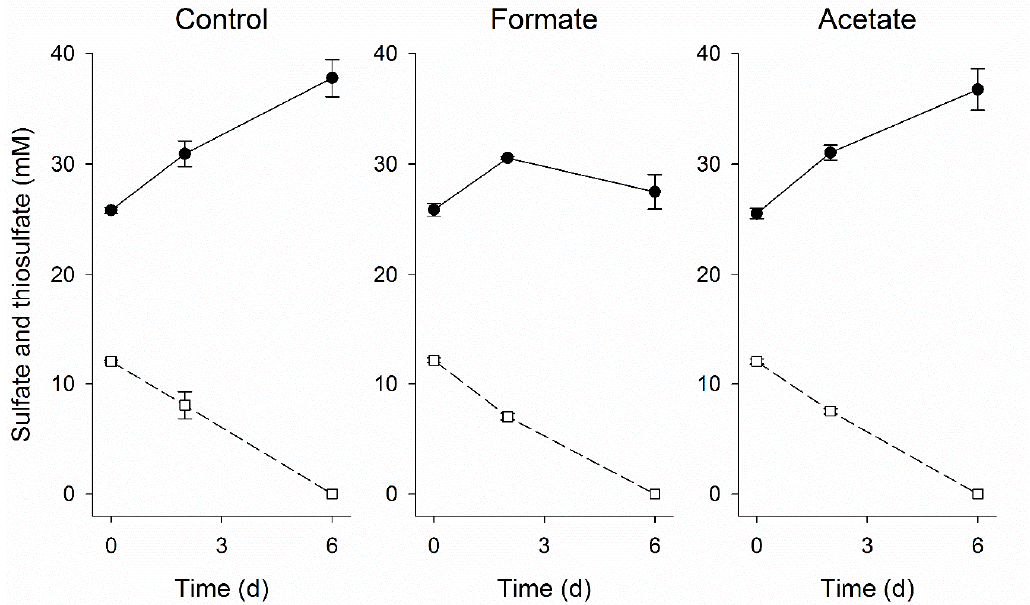
Figure 7. Sulfate ( ● ) and thiosulfate ( □ ) conversion during the batch tests with biomass from day 90 incubated with 25% CO in the gas phase. The control test was performed with regular medium while 25 mM formate and 12.5 mM acetate were added to the formate and acetate experiments, respectively. Vertical bars represent the standard deviation among triplicates.